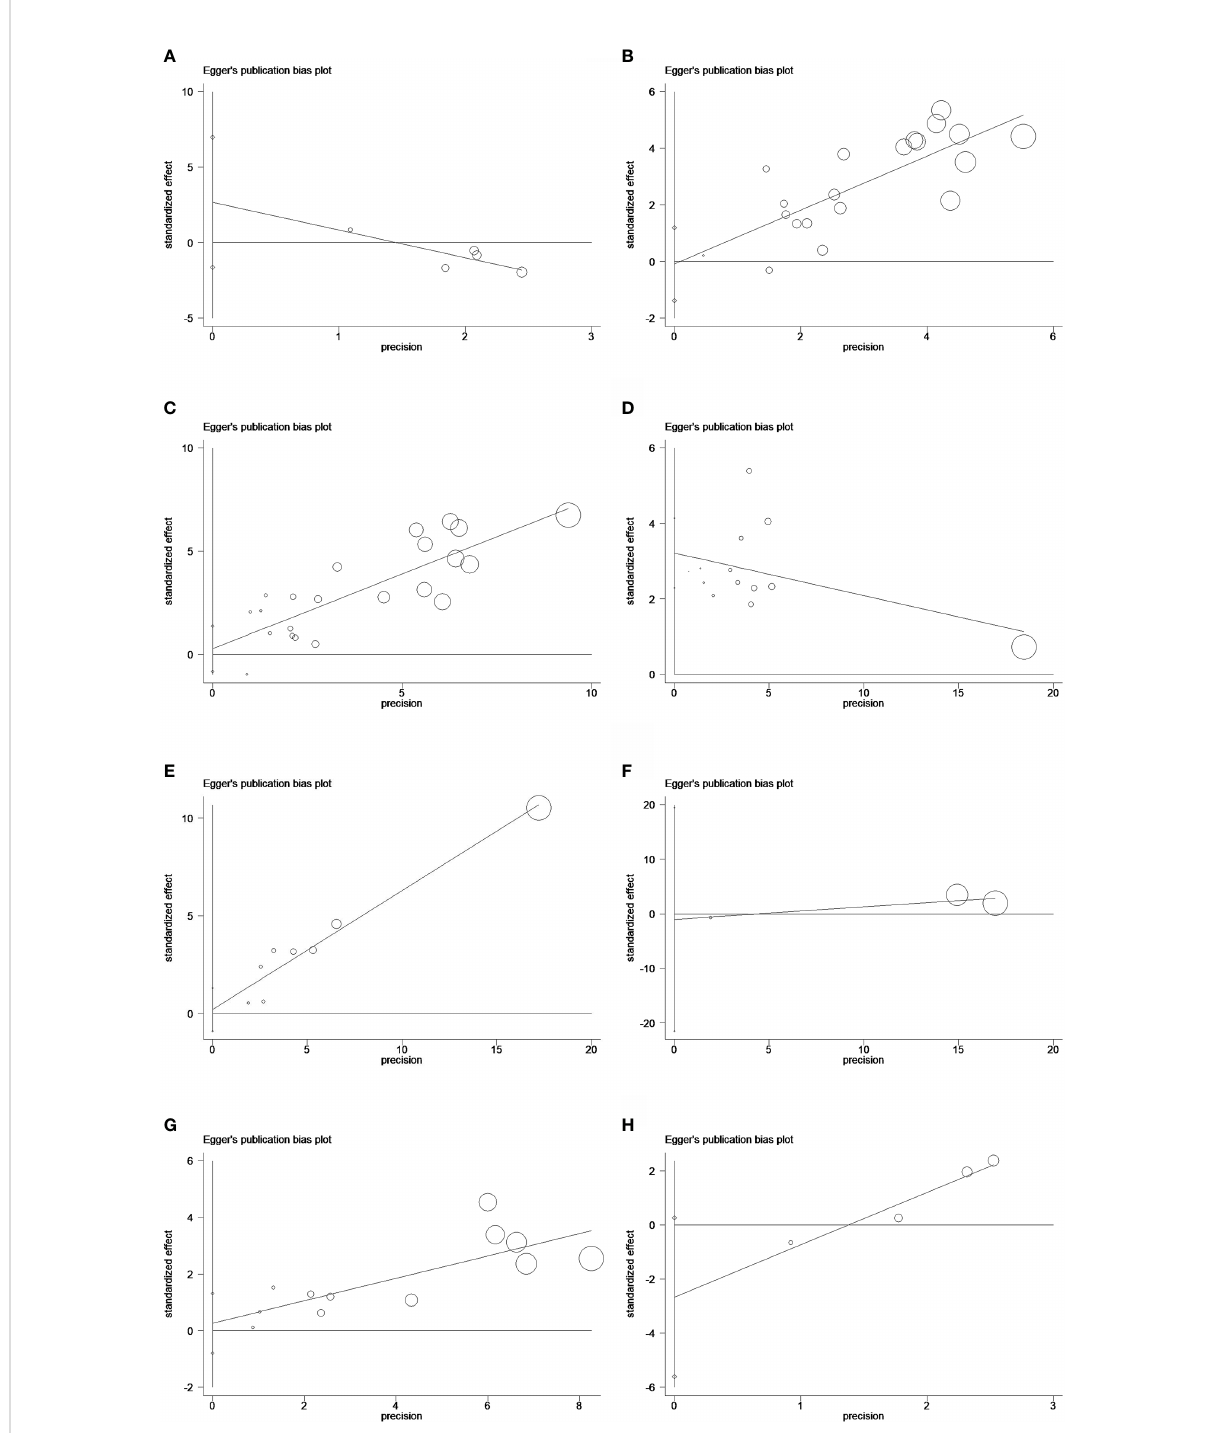
FIGURE 6 Egger ’ s publication bias plots of peripheral (A) IL-2, (B) IL-6, and (C) IL-8 in univariate analysis of OS and (D) IL-6, (E) IL-8, and (F) IL-15 in multivariable analysis of OS and (G) IL-8 and (H) IL-10 in univariate analysis of